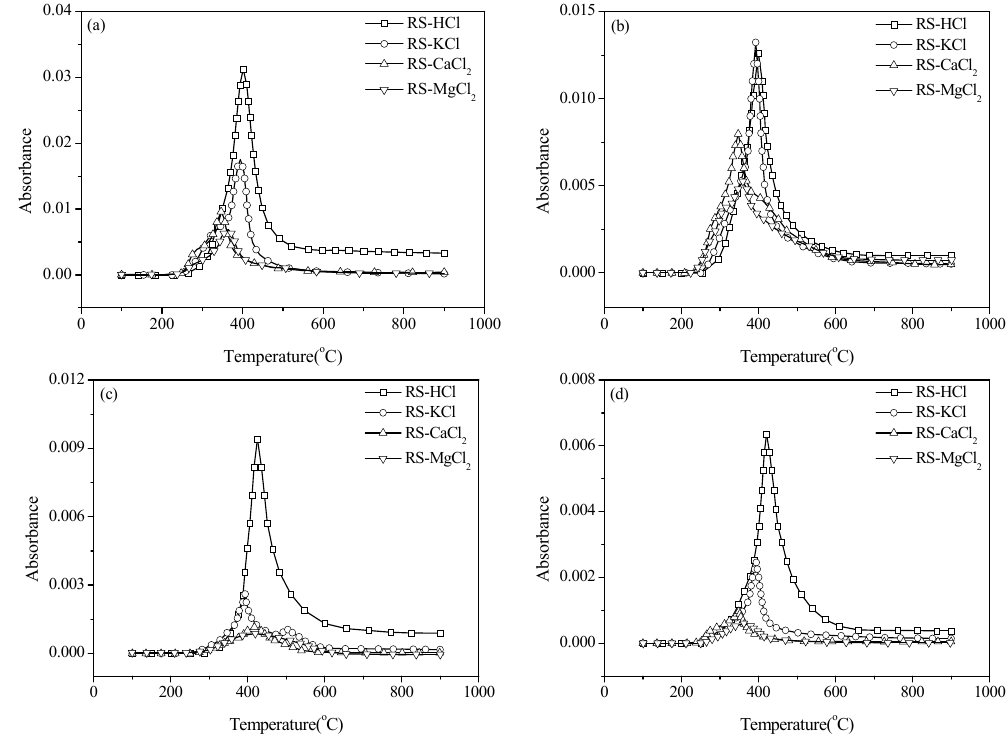
Figure 6. Release of N ‐ compounds with alkaline earth metallic specie (AAEM) additives ( a ) NH 3 ; ( b ) HCN; ( c ) HNCO; ( d ) NO.